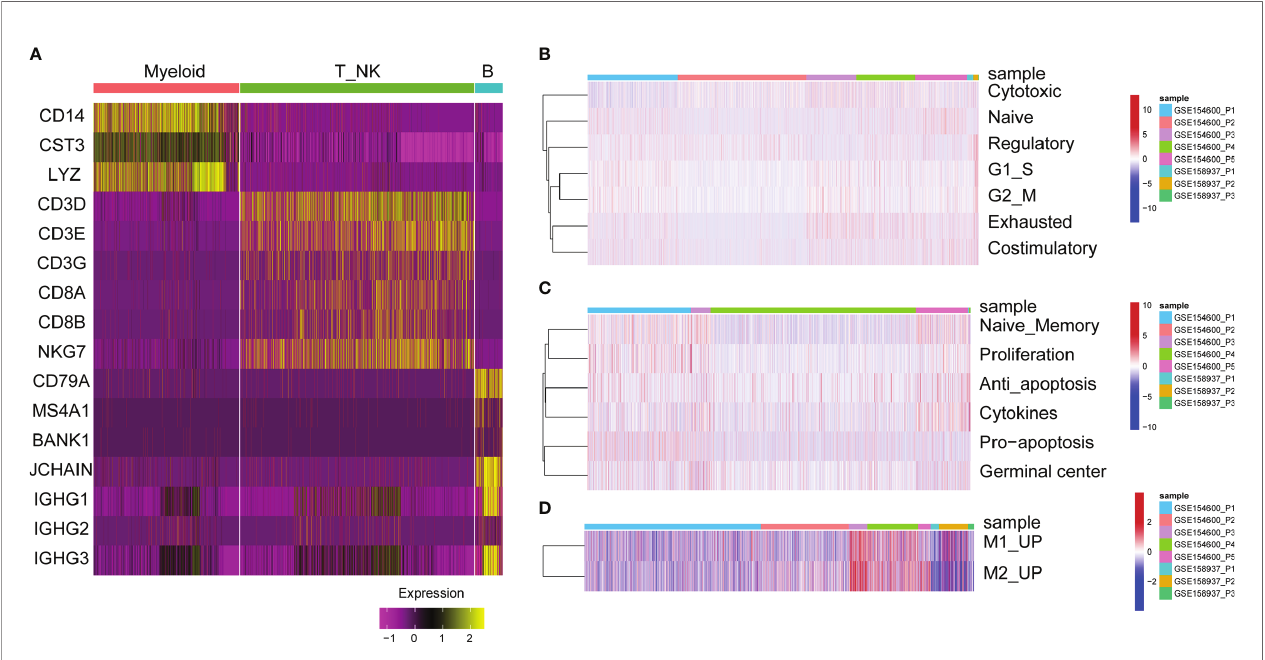
FIGURE 3 | GSVA enrichment analysis of immune cells. (A) Heat map of signi fi cant marker gene expression in immune cells. (B) T cell characterization in OC. GSVA enrichment fractions of naive T cell, co-stimulatory T cells, Regulatory T cells, and exhausted T cells related gene sets. (C) B cell characterization in OC. GSVA enrichment fraction of naive B cells, proliferative, anti-apoptotic, pro-apoptotic, cytokine and germinal center related gene sets. (D) Characteristics of myeloid cells in OC. GSVA enrichment fraction of relating gene sets in M1 and M2-like myeloid